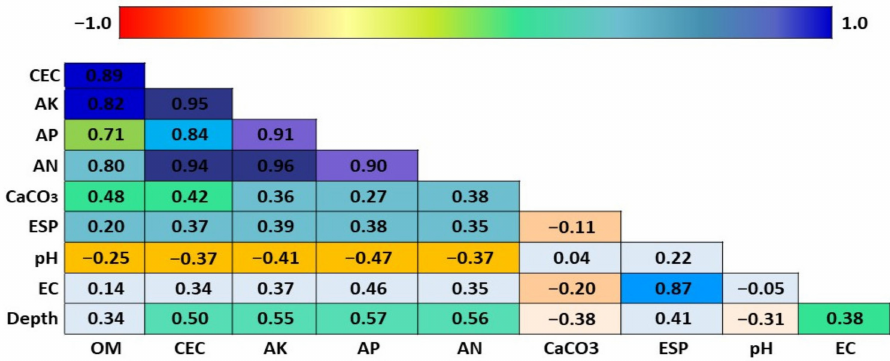
Figure 5. Correlation plot showing coefficients between soil properties. Note: p < 0.01 and/or p < 0.05. AK, AP, and AN represent available potassium, phosphorus, and nitrogen, respectively.